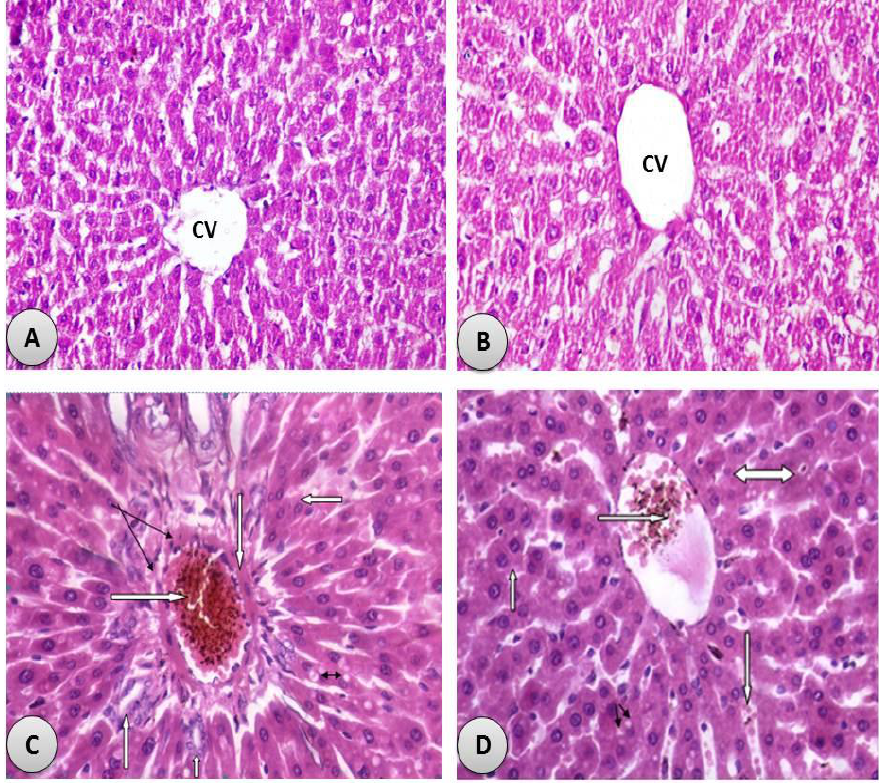
Figure 5. Photomicrograph of H&E-stained sections in the liver: ( A ) control group showed normal hepatic cells and the normal central vein (thin arrow) (H&E×400); ( B ) R. damascene -treated group showed normal hepatic structures with normally sized central vein (CV) (H&E×400); ( C ) CdCl 2 treated group showing toxicity in the form of hypertrophy of hepatocytes with appearance of bi- nucleated hepatocytes and increased eosinophilia , granular cytoplasm and vesicular nuclei (Right forwarded white arrow) , the portal tract shows severe congestion of the portal vein which is filled with haemorrhage and necrotic tissues ( White forwarded white arrow) , ductular reaction (new bile ducts formation) at the periphery of portal tract (Black arrow) with perivenular fibrosis and mild hyalinisation in its wall (Upward white arrow) , infiltration by inflammatory cells of the portal tract (Two headed arrow) and ballooning degeneration in some hepatocytes (H&E×400). ( D ): CdCl 2 combined with R. damascena showing hepatic tissues with mild toxicity in the form of hypertrophy of hepatocytes with granular eosinophilic cytoplasm and vesicular nuclei and appearance of some binucleated cells , with mild congested central vein, ballooning degeneration of some hepatocytes (Two sided arrow) and few dilated congested blood sinusoids (H&E×400).